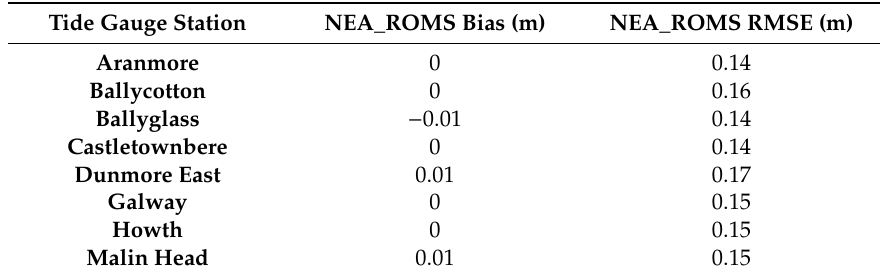
Table 3. Bias and RMSE of error for modelled minus observed at Irish tide gauge locations in meters. Tide Gauge Station NEA_ROMS Bias (m) NEA_ROMS RMSE (m) Aranmore 0 0.14 0 0.16 −